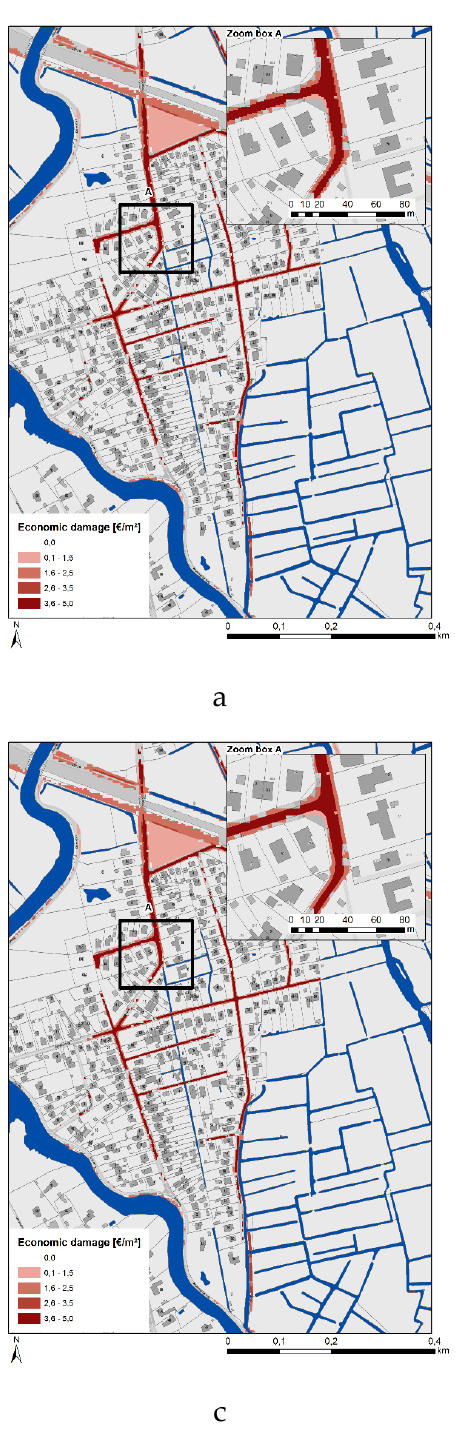
Figure 24. Economic damage calculation resulting from fluvial flood with LATIS with 1m resolution ( a ), 5 m resolution ( b ), and FLIAT ( c ).